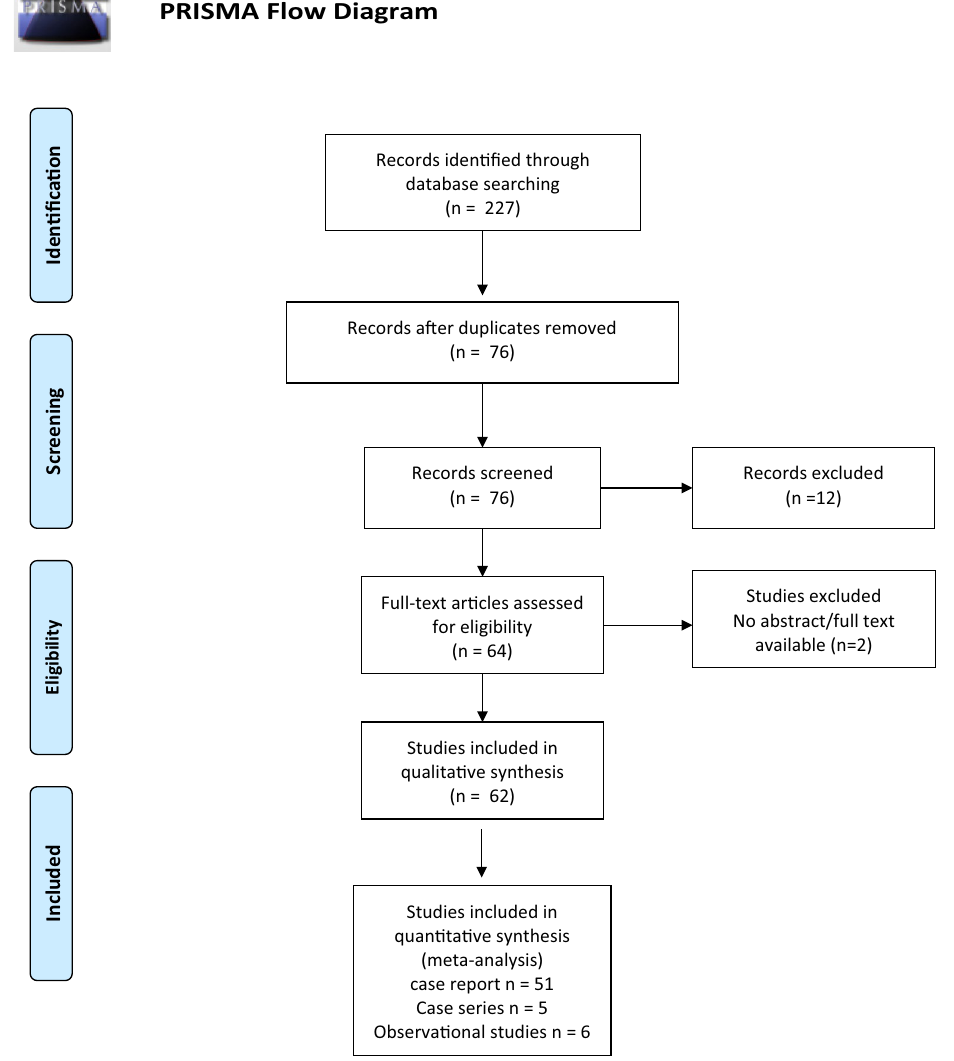
Figure 1. PRISMA flowchart of selected studies.